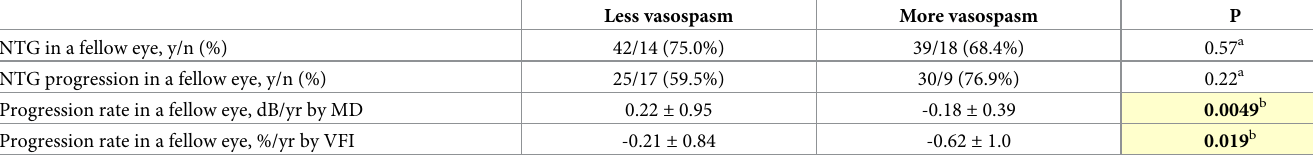
Table 6. Comparison of the characteristics of fellow eyes of patients according to the degree of peripheral